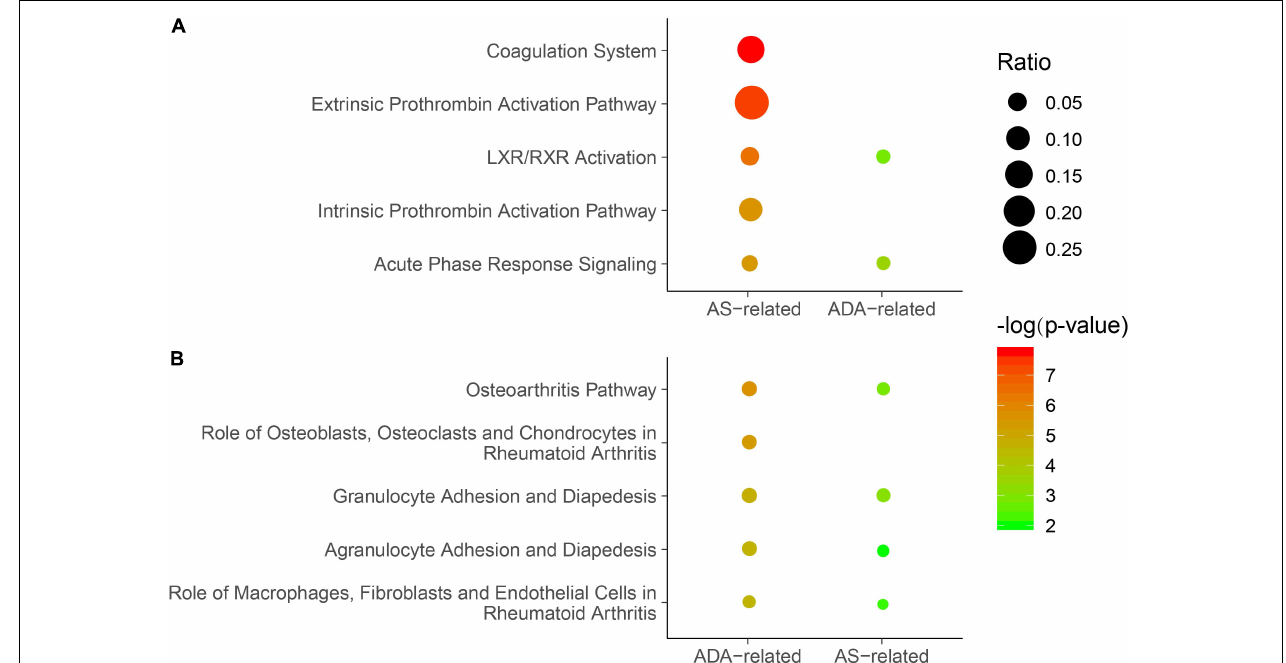
FIGURE 2 | Enriched canonical pathways in which the DEPs were involved. (A) The top five canonical pathways identified for the AS-related DEPs. Significance of the pathways based on AS-related or ADA-related DEPs was displayed. (B) The top five canonical pathways identified for the ADA-related DEPs. Significance of the pathways based on ADA-related or AS-related DEPs was shown. P -values were calculated using Fisher’s exact test. Non-significant P -values ( P -value ≥ 0.05) were not shown. Dots represent the ratio of the number of DEPs to the total number of proteins in each pathway. DEP, differentially expressed protein; AS, ankylosing spondylitis; ADA,